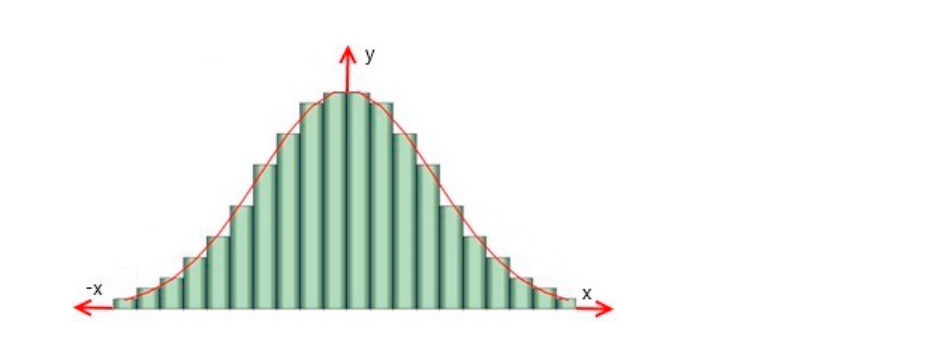
Figure 10. Differential distribution curve y = ϕ (u), where x = u = (e i − ξ )/( ξ · σ ) based on the histogram.